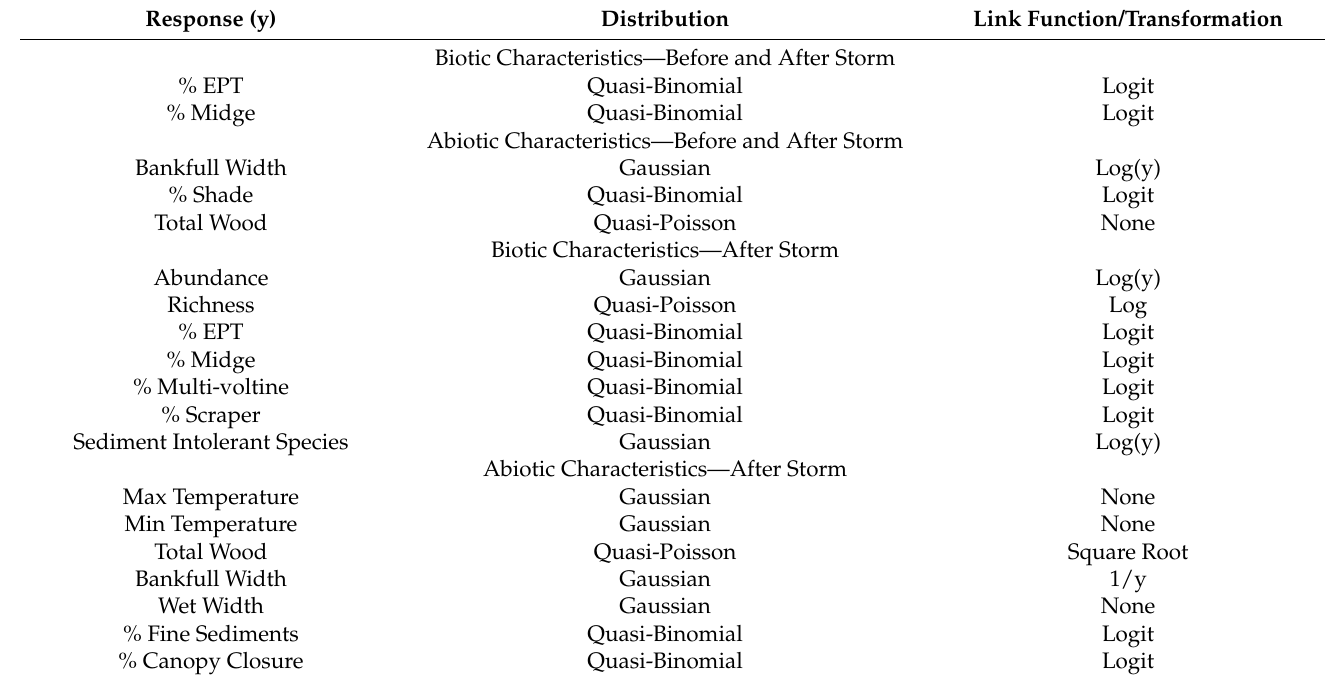
Table 2. The distributions and link functions of the GLMM models for pre- and post-storm biotic and abiotic response variables and 2008–2016 storm biotic and abiotic response